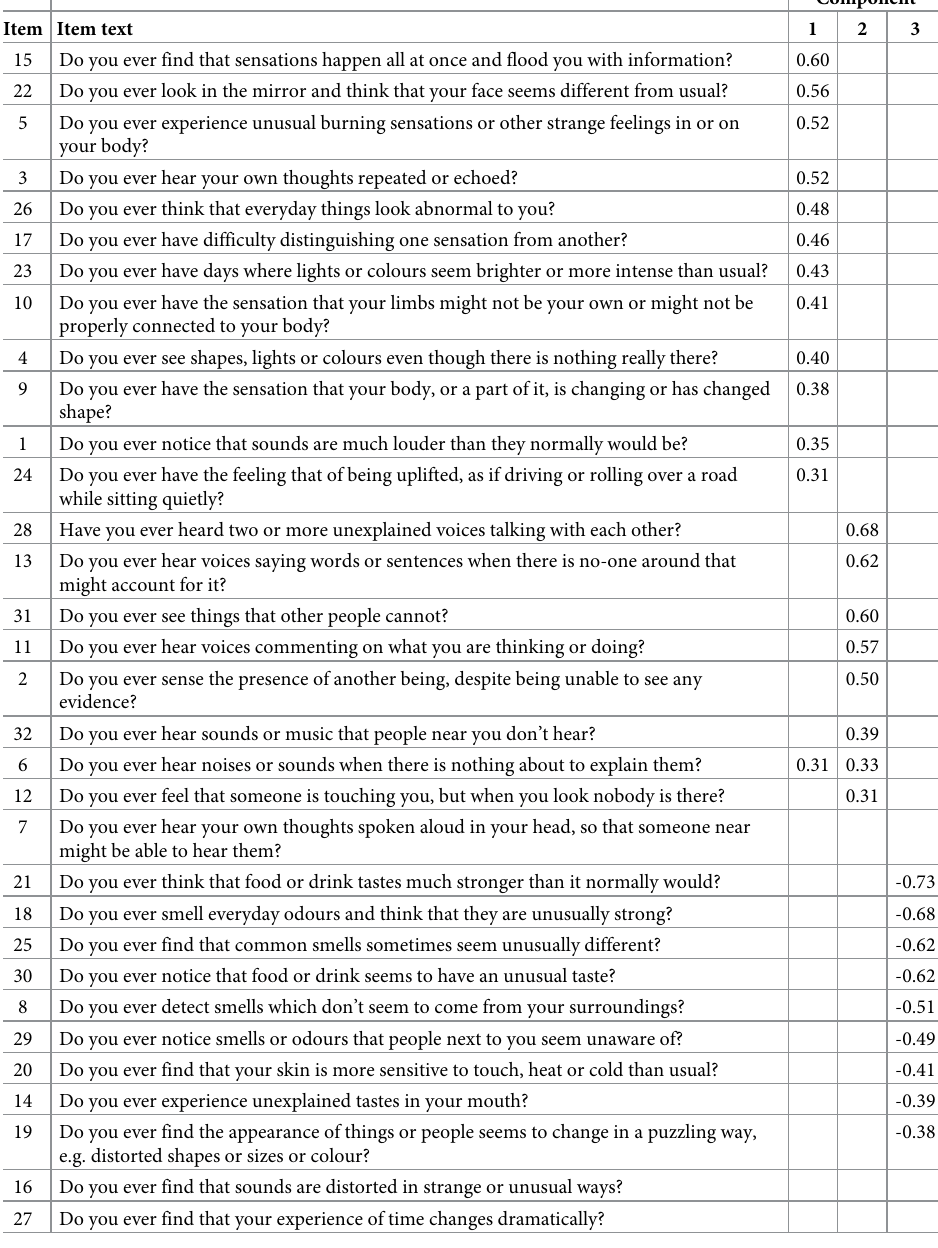
Table 2. CAPS items and factor loading after principal components analysis (oblimin rotation) of nonclinical sample responses.